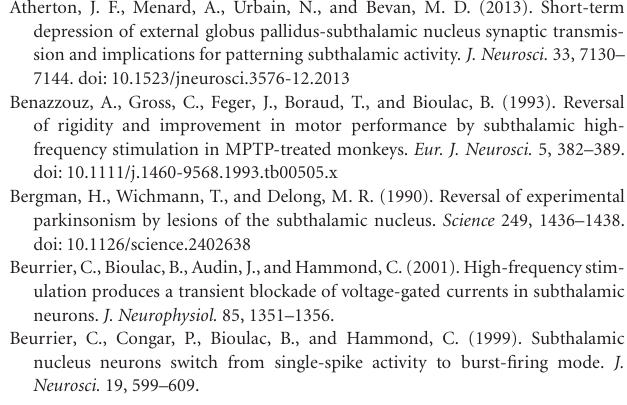
firing rate of pallidal neurons in response to each pulse of 10 Hz (i, n = 9) and 100 Hz (ii, n = 11) stimulation of the STN. Thick and dashed red lines indicate the average ± 2 SD of pre-stimulus frequency, respectively. (C) Box plots showing the differences in firing rate before and after 10 Hz (i) or 100 Hz (ii) stimulation (* p < 0.05 and ** p <